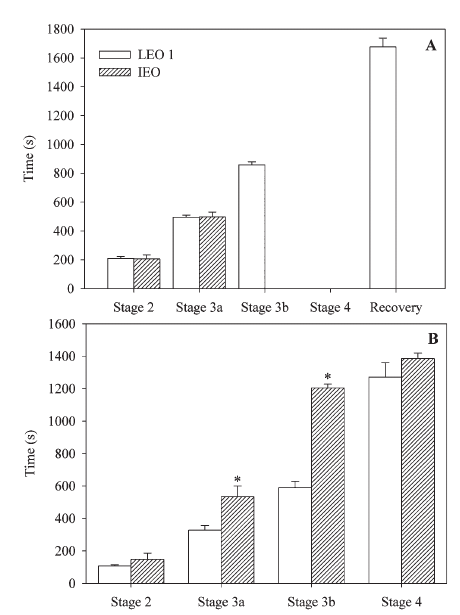
Figure 1. Anesthetic activity of essential oils (EO) of Hyptis mutabilis obtained from leaf (LEO 1) and inflorescence (IEO) at concentrations of 172 mg/L ( A ) and 344 mg/L ( B ) in silver catfish juveniles. Stages of anesthesia: deep sedation (stage 2), partial loss of equilibrium (stage 3a), total loss of equilibrium (stage 3b), and anesthesia (stage 4) (22). Maximum observation time was 30 min. Time to reach each stage is given in seconds (s). Data are reported as means±SE (n=6). *P , 0.05, compared to LEO 1 ( t -test or Mann-Whitney